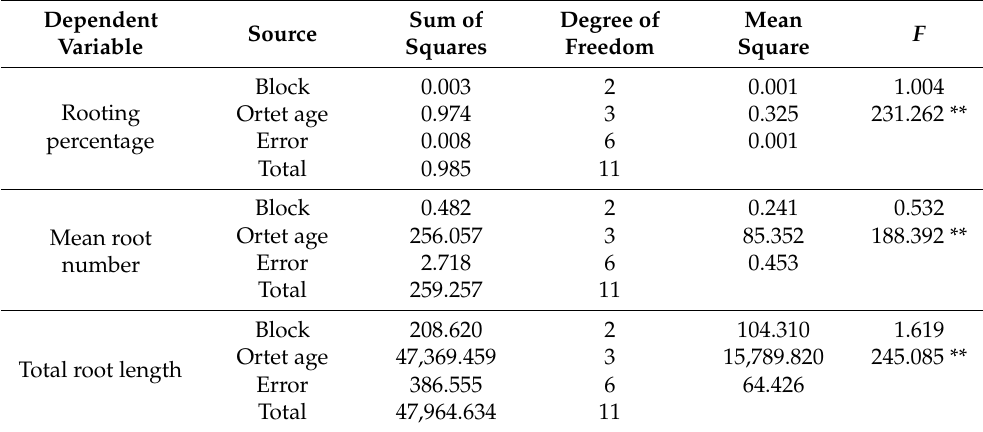
Table 1. Analysis of variance of different ortet ages on rooting percentage, mean root number and mean root length. Dependent Variable